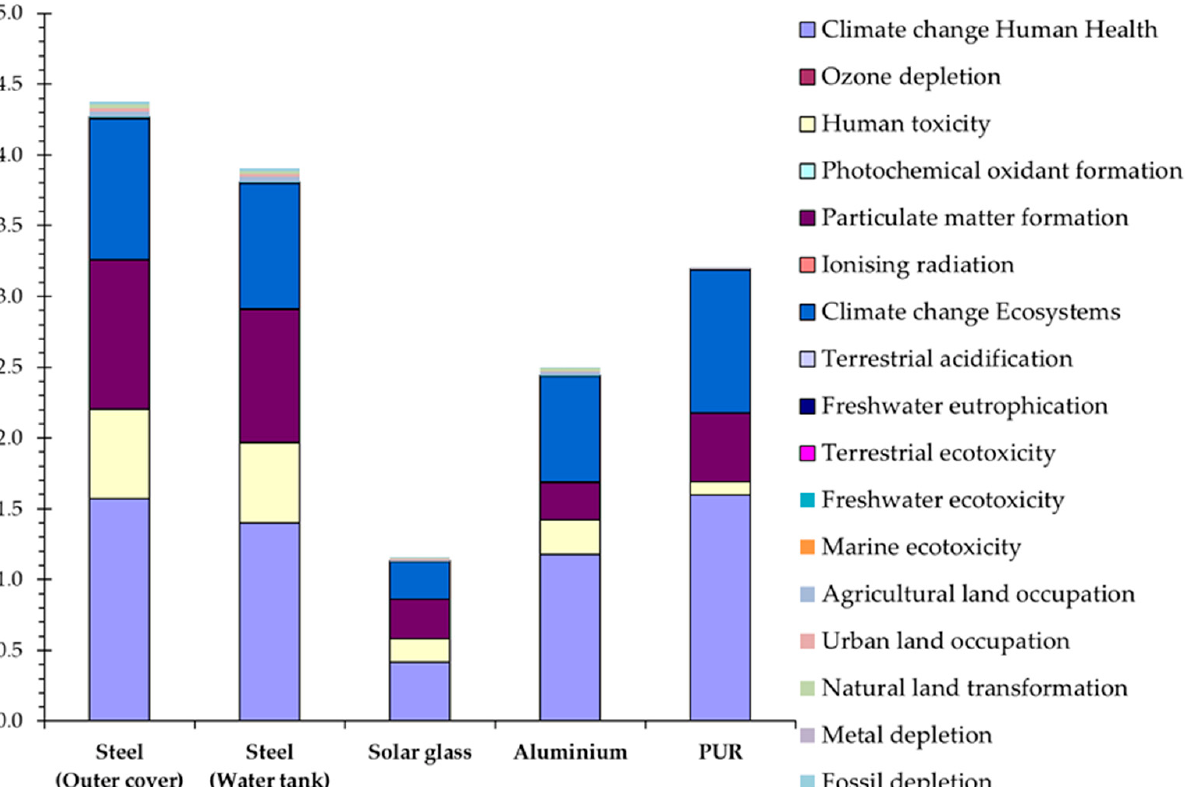
Table 1. Quantified technical details of employed materials for the ICS system. Absorbing Reflector Water Tank Other Parts Material Mass (kg) Material Mass (kg) Material Mass (kg) Steel 44.47 Steel 29.40 Plastic tube 2 Aluminium 6.49 Magnesium 0.10 Glass fibre 2 Solar Glass 8.74 PUR 12.02 Total 71.72 29.50 4 The environmental and energy analysis of the studied system is investigated through the LCA method, which follows the ISO standards 14040, 14044 [36,37] and is implemented with SimaPro 8.5 [38] and ecoinvent 3.4 database [39]. The environmental impact assess- ment methodology used is Recipe Endpoint 2016 Hierarchist [40]. Figure 3 summarizes the environmental footprint of the studied system.